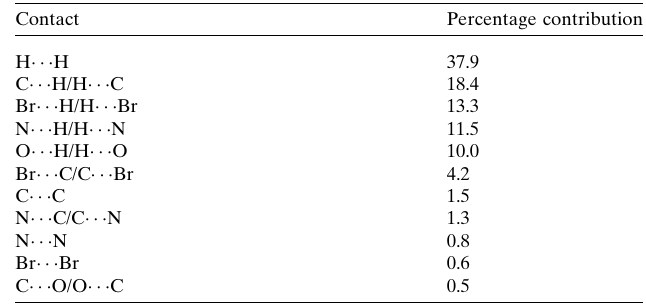
Table 4 Summary of short interatomic contacts (A˚ ) in compound (II). Contact